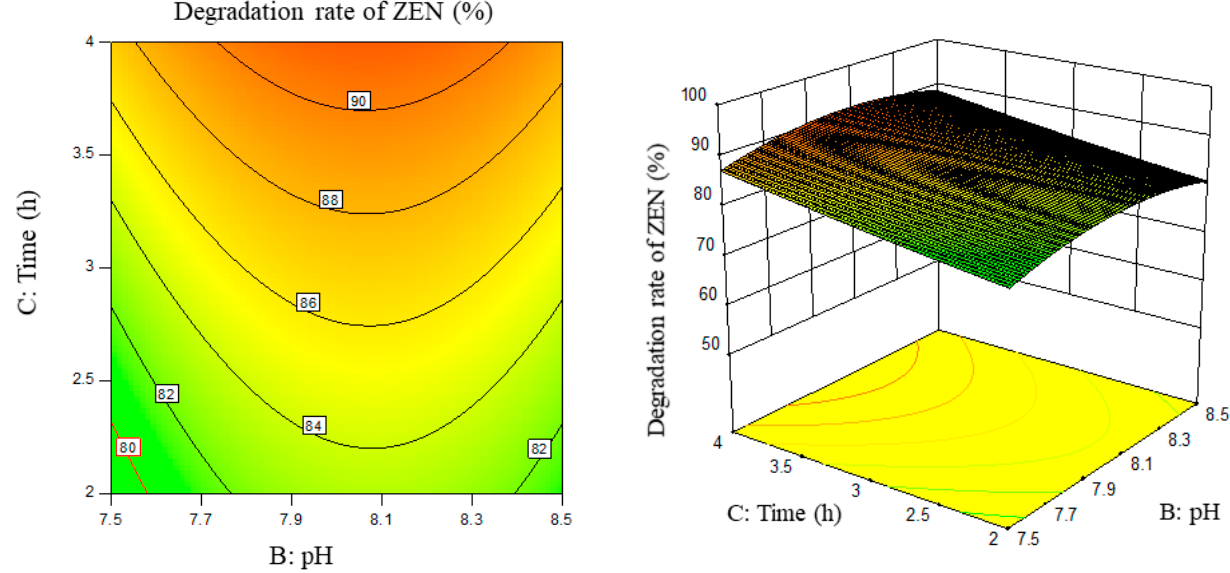
Figure 8. PH, time, and their interaction vs. the response surface and contour line of the degradation rate of ZEN.